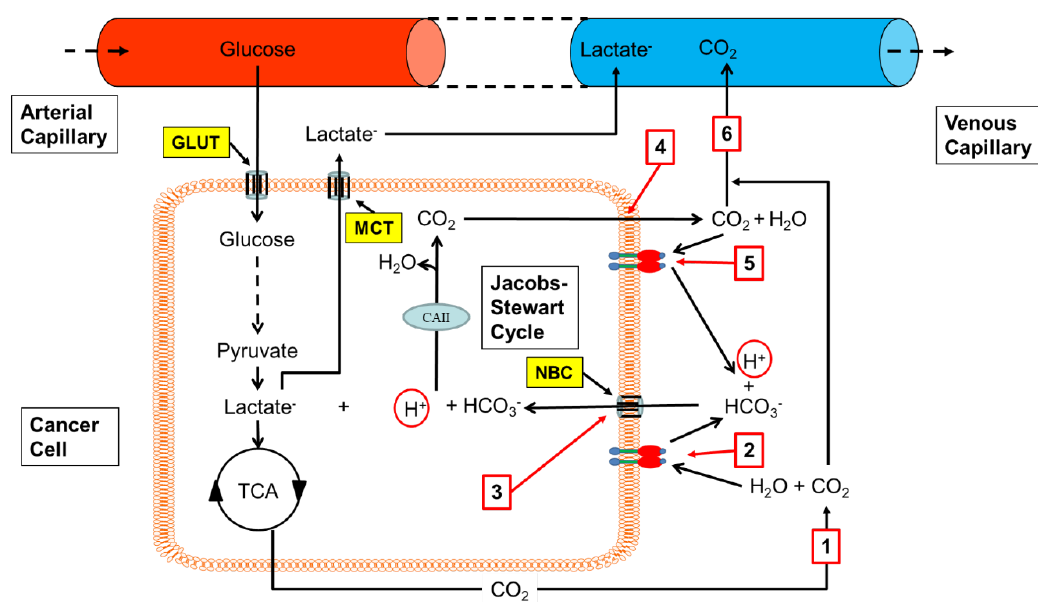
Figure 2. A Jacobs–Stewart Cycle helps hypoxic cancer cells extrude H + produced by anaerobic glycolysis. 1. CO 2 diffuses from the cancer cell into the extracellular space; 2. CAIX on the extracellular surface of the hypoxic cancer cell catalyses the hydration of CO 2 to form H + and HCO 3 − ; 3. The HCO 3 − enters the hypoxic cancer cell via the Na + /HCO 3 − cotransporter and binds H + from lactic acid, catalysed by CAII, thus forming CO 2 ; 4. The CO 2 diffuses from the hypoxic cancer cell into the extracellular space, along its concentration gradient; 5. On the extracellular surface of the hypoxic cancer cell, CAIX catalyses the hydration of the CO 2 to form H + and HCO 3 − . The HCO 3 − provides further substrate to repeat stage 3 of the cycle, and an equivalent amount of H + that was originally inside the hypoxic cancer cell (ringed in red) is now in the extracellular fluid; 6. Accumulating CO 2 diffuses to a capillary. GLUT, glucose transporter; MCT, monocarboxylate transporter; NBC, Na + /HCO3 − cotransporter.